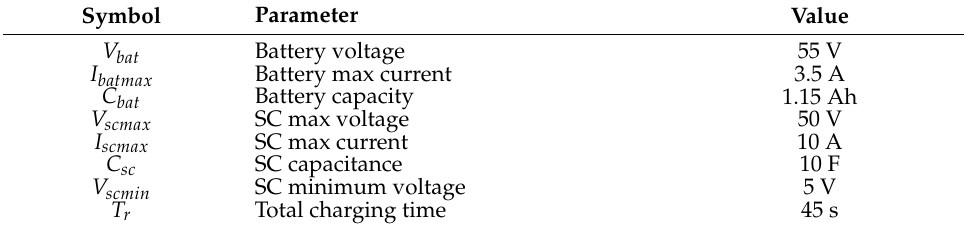
Table 2. HESS specifications. SC: